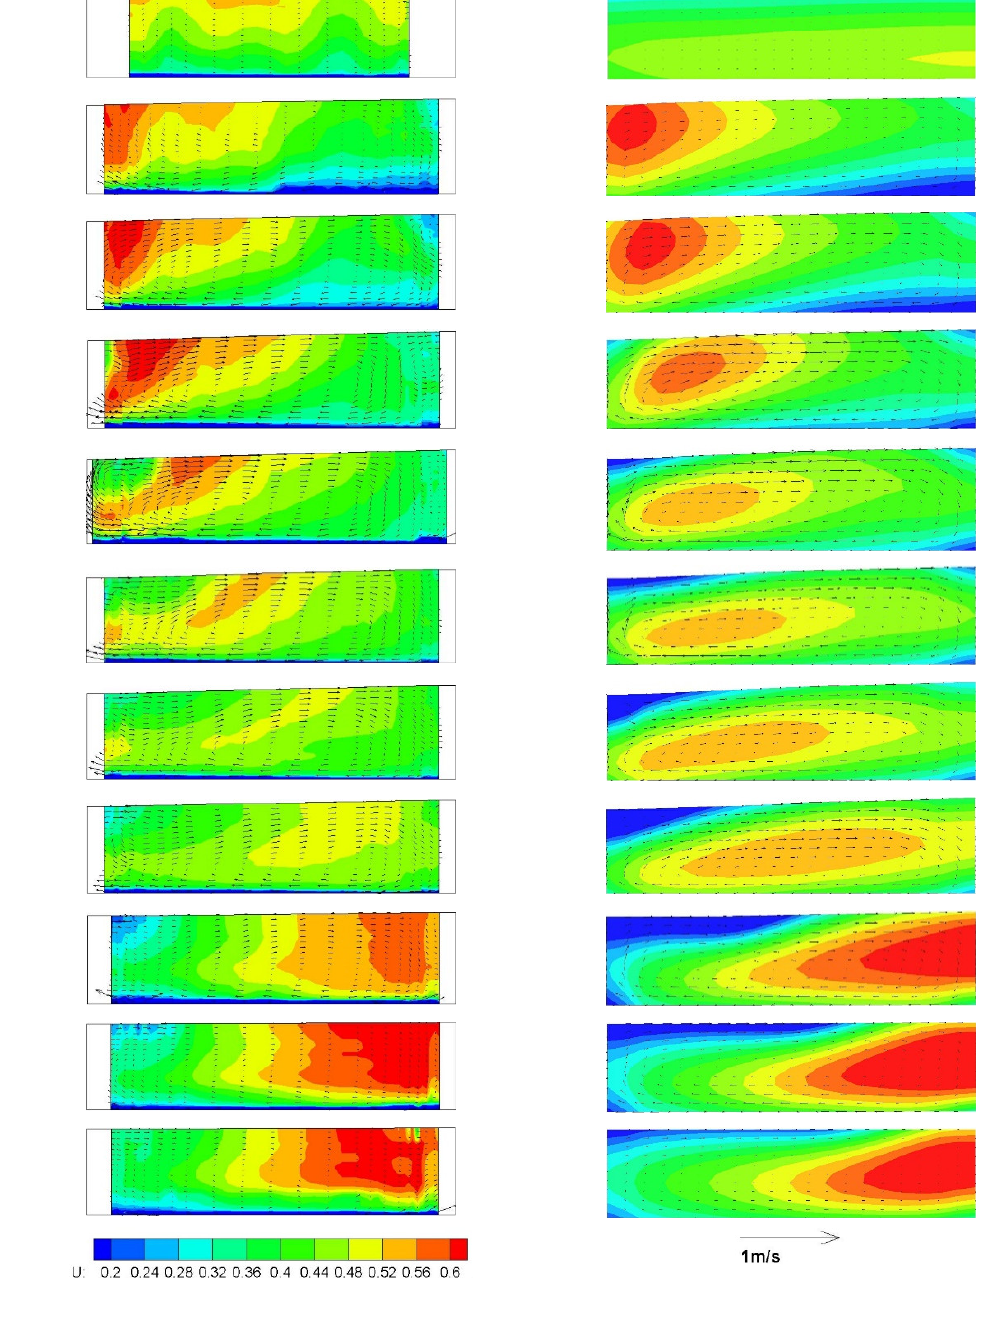
Figure 5. Stream-wise velocities (contour) and transversal velocities (vector): measured ( left ) and predicted ( right ). From top to bottom, the cross sections are M05, S15, S30, S60, S90, S120, S150, S180, P05, P15, and P25, as shown in Figure 1a.